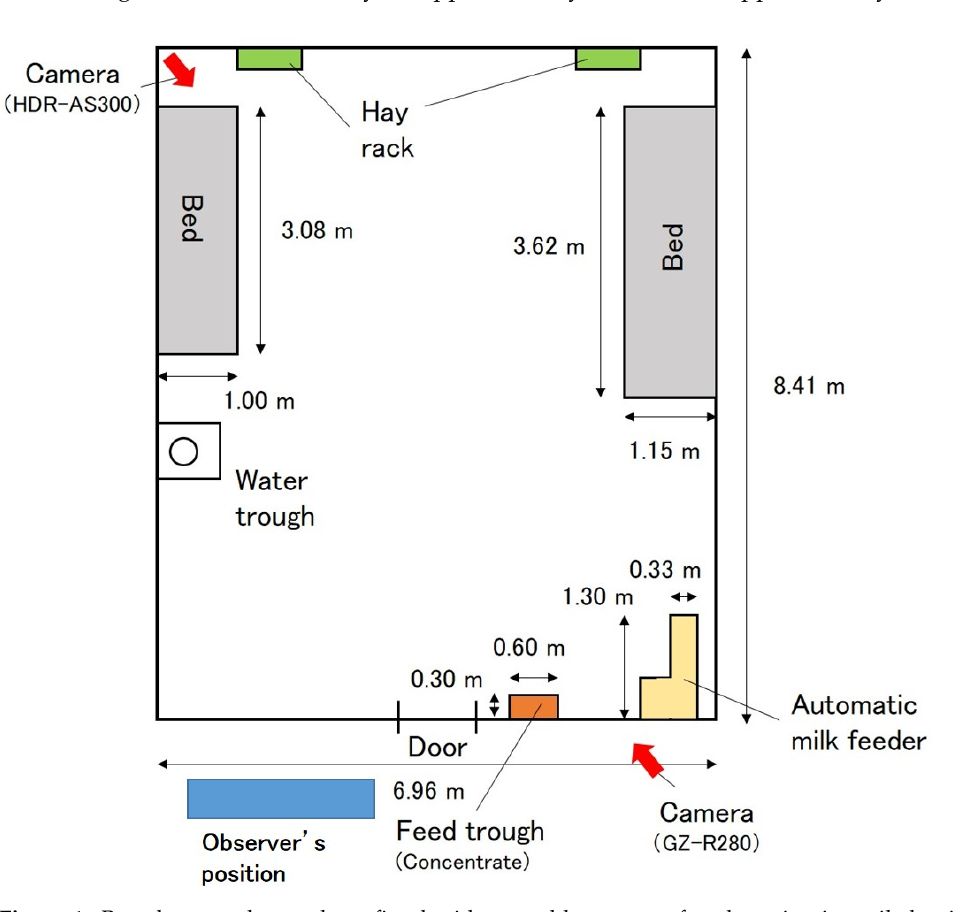
Figure 1. Barn layout where calves, fitted with wearable cameras for observing juvenile bovine behavior, were kept during the study. The position and direction of the fixed cameras are indicated by the red arrows.